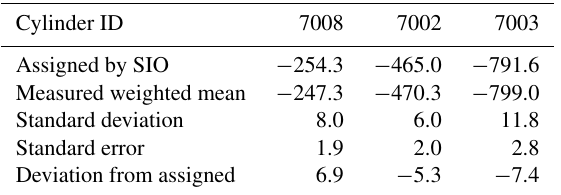
Table 3. Comparison of the averaged measured values of the Scripps primary standards against their assigned values in per